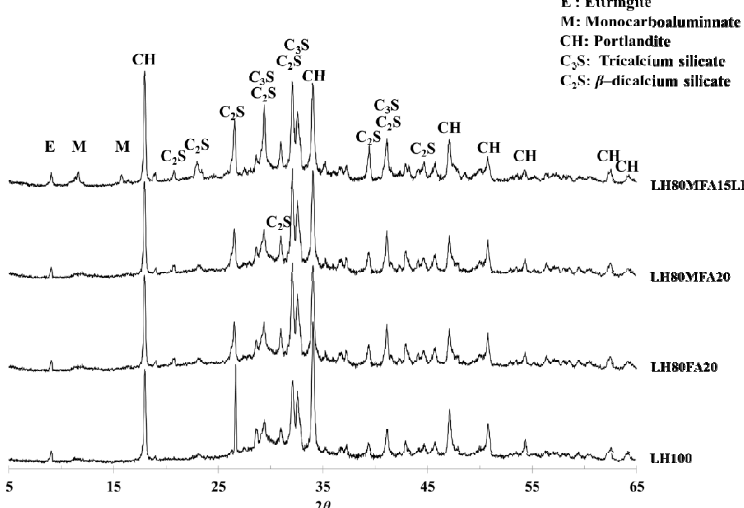
Figure 9. X-ray diffraction (XRD) patterns at 28 days.